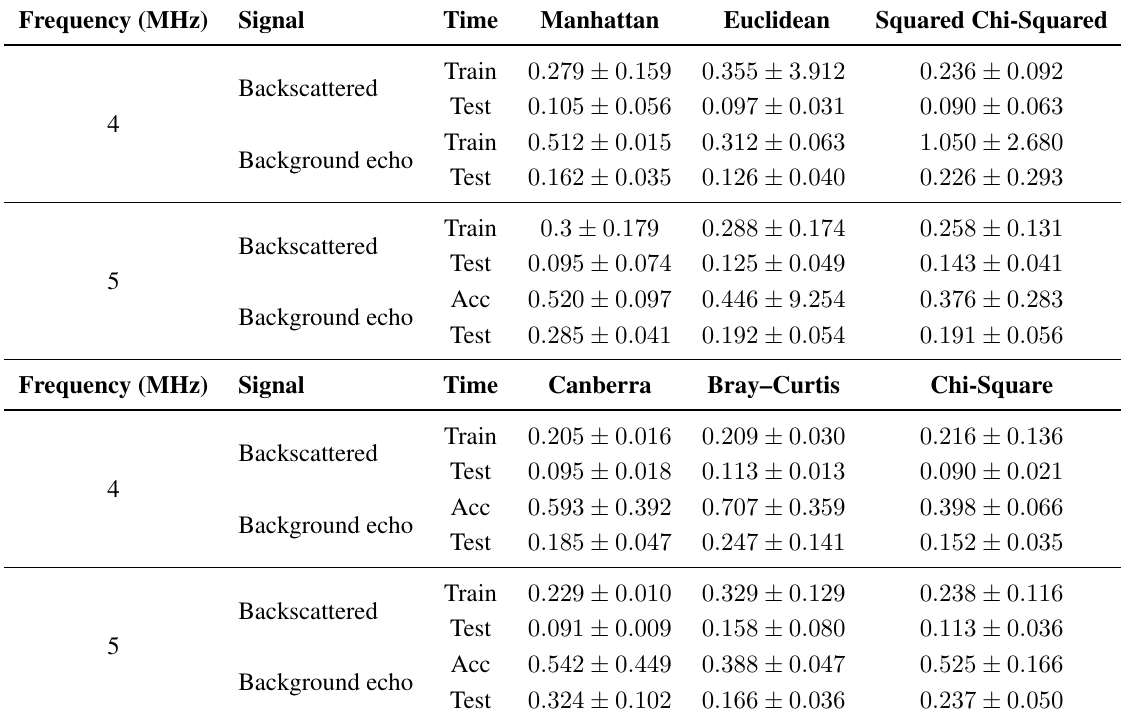
Table 6. Average of training and testing times in milliseconds for the 4- and 5-MHz frequency signals at 650 ◦